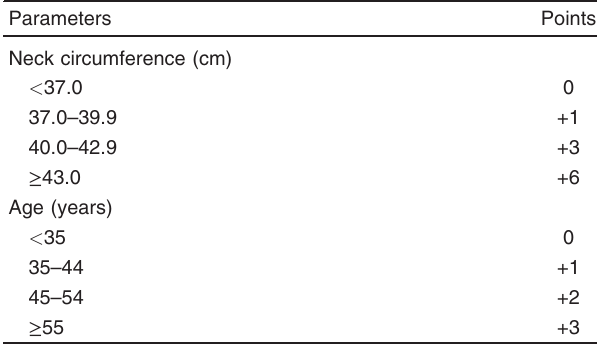
Conflicts of interest There are no conflicts of